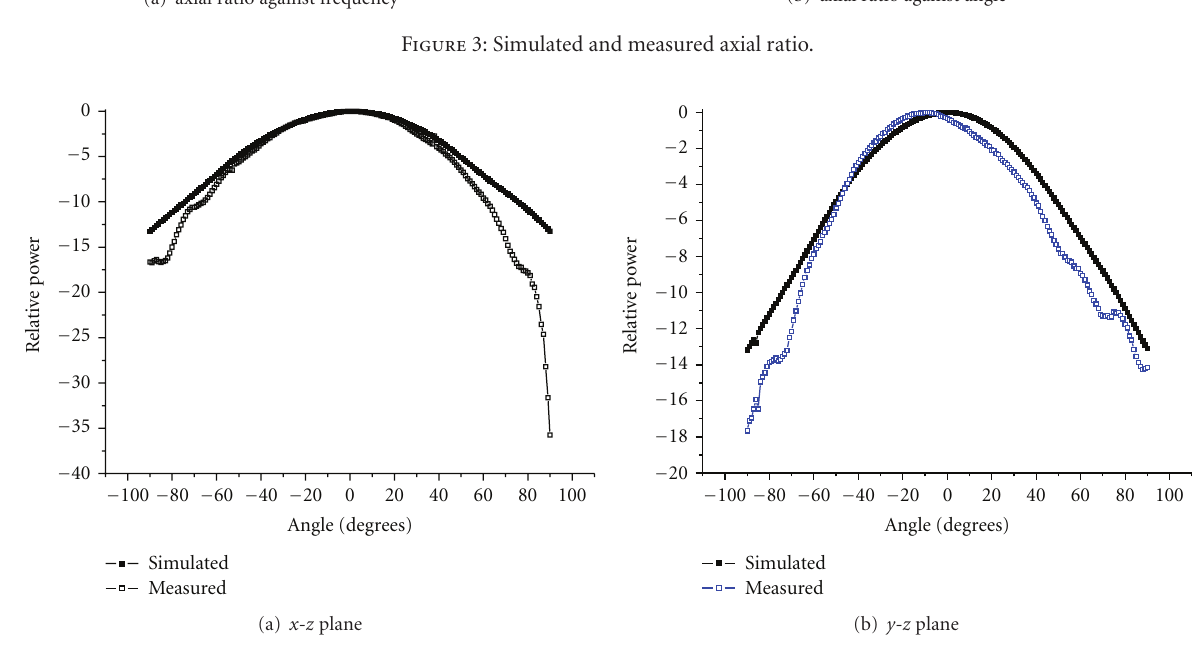
Figure 4: Simulated and measured radiation patterns at central